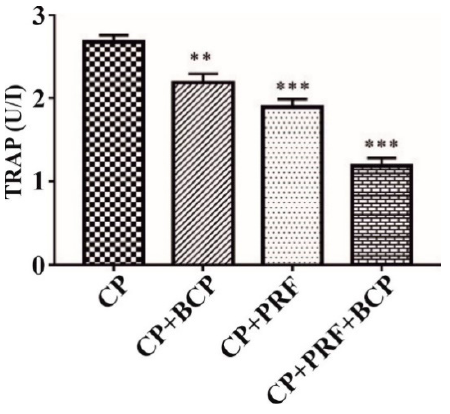
Figure 1. TRAP activity images. All data are presented by mean ± SD. Results are expressed as the mean ± SD. The comparisons were made among CP and BCP, CP and PRF, and CP and PRF/BCP. (** p < 0.01; *** p < 0.001).